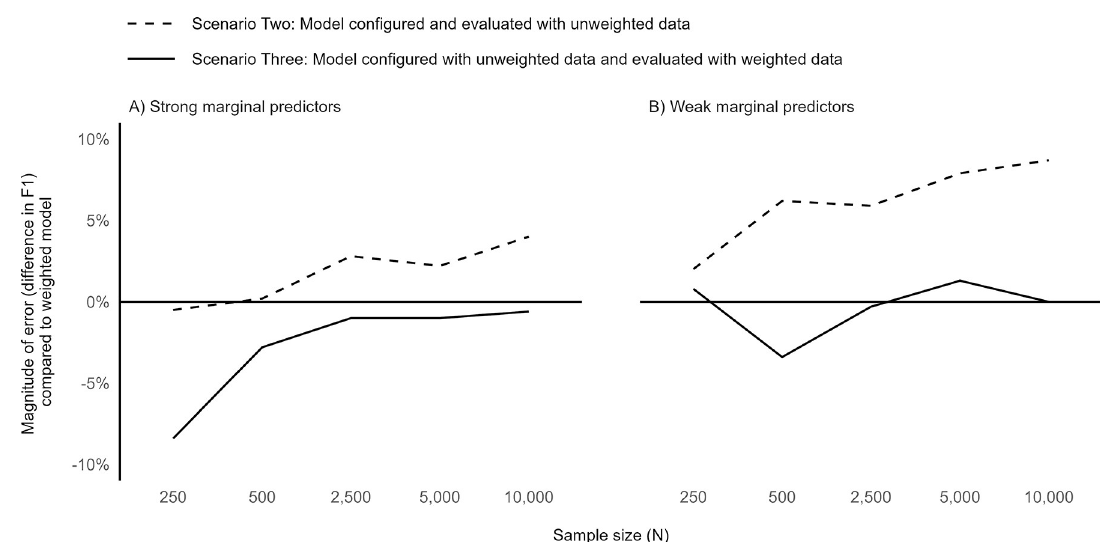
Fig 3. Performance of unweighted versus weighted gradient boosting model implementations by predictor strength and sample size.